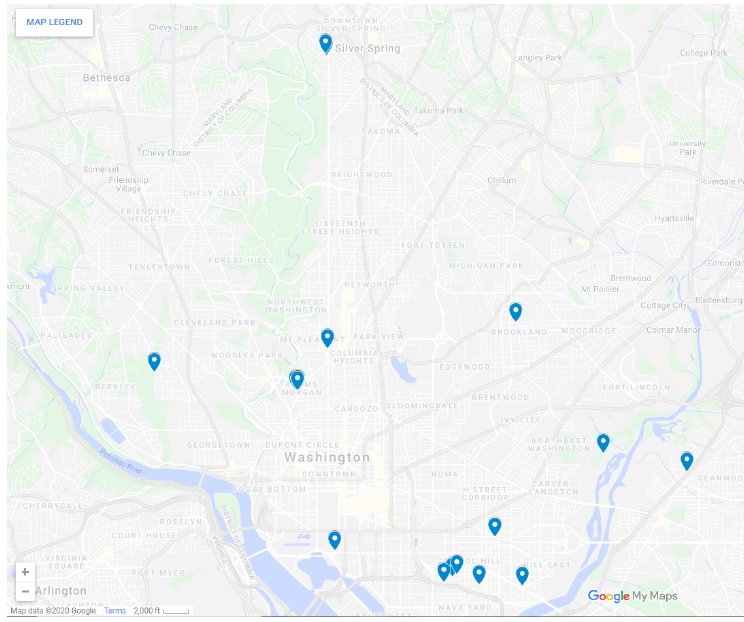
Figure 13. Lambsquarters map resulting from Mission